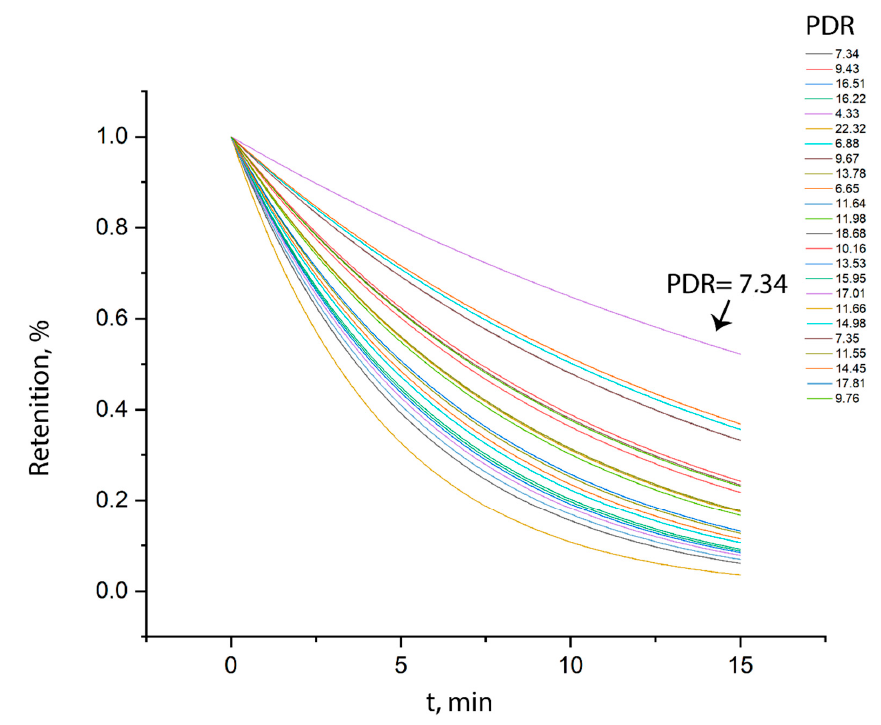
Figure 6. Plasma dye elimination curves corresponding to individual series.